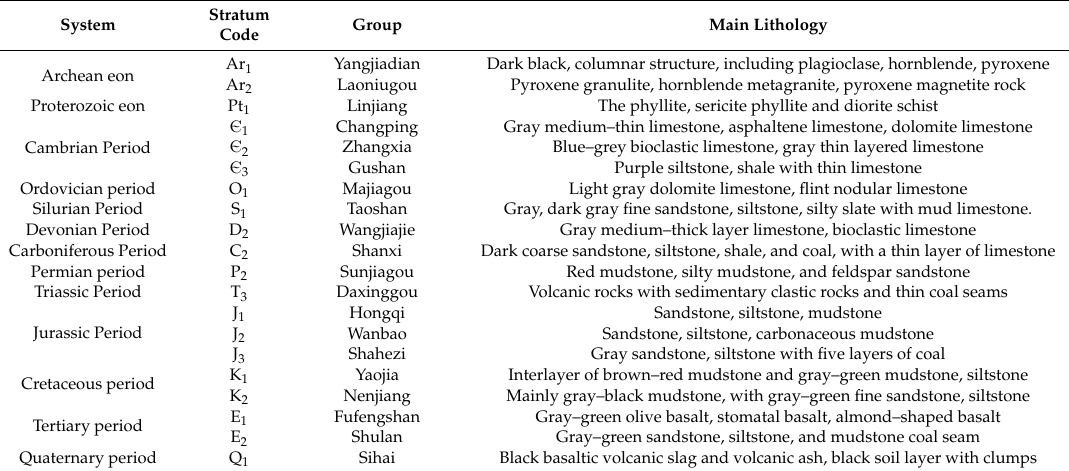
Table 1. Main geology and lithology in the study